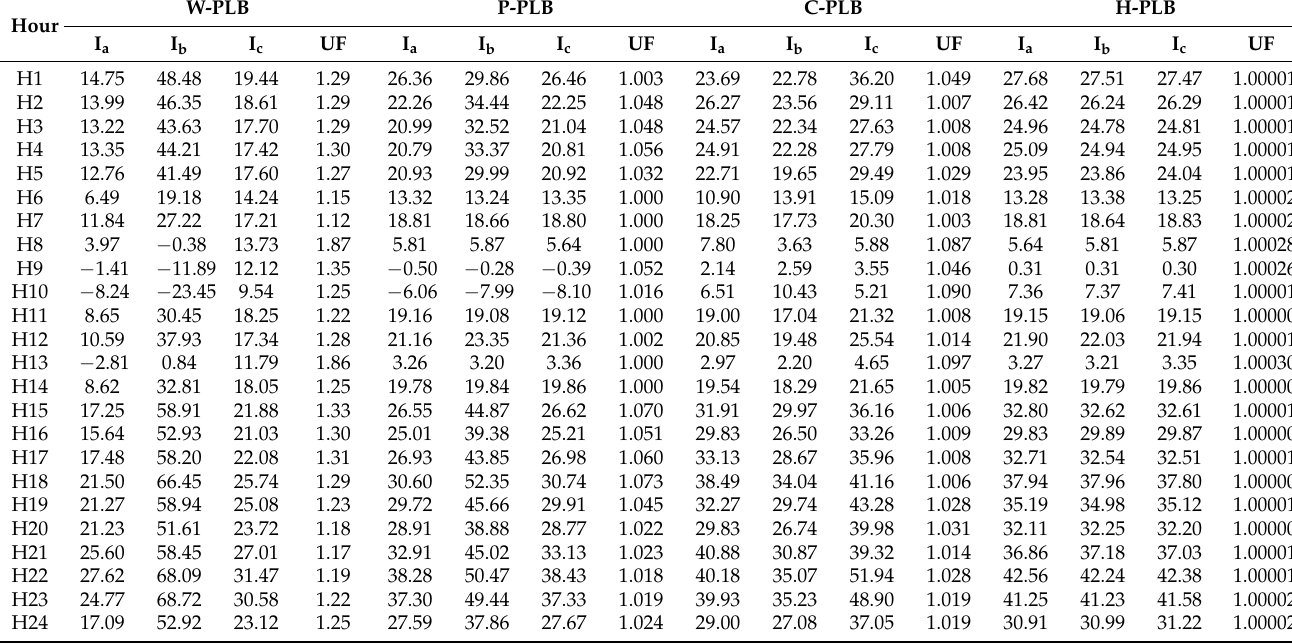
P-PLB algorithm. Table 9 contains details on the hourly total power losses calculated for all analysed cases. Table 7. The hourly phase currents and the unbalance factor calculated for all analysed cases *, in (kW).